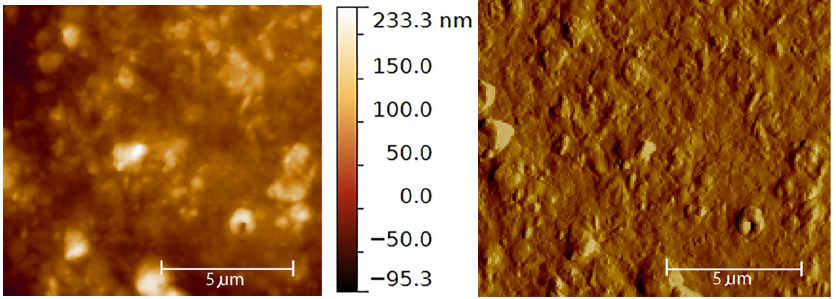
Figure 2. Underwater AFM images, performed in non-contact mode, of the SQ-Dox SLN1 formulation after sample deposition on a mica support: topography on the left and amplitude on the